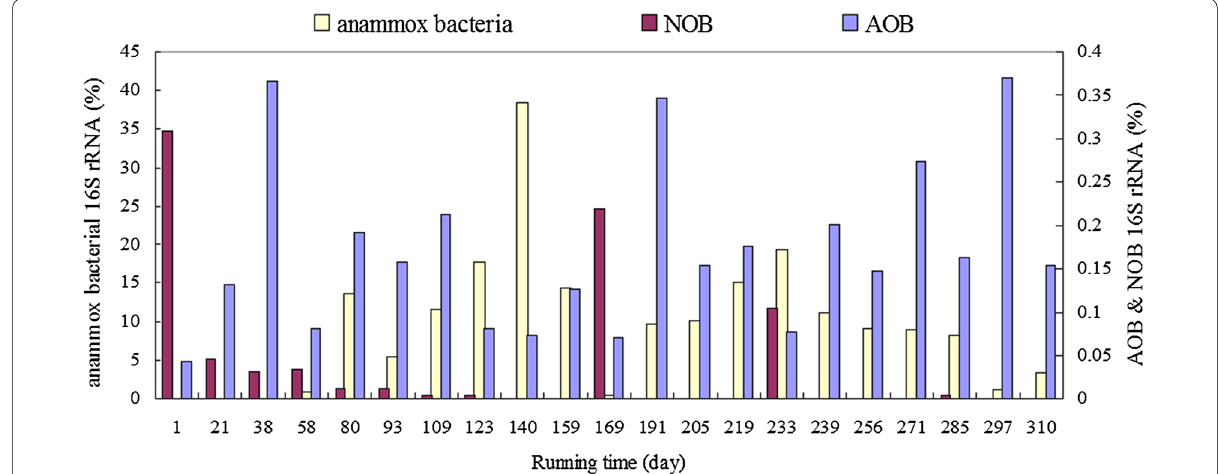
Fig. 5 Relative abundance of sequences related to anammox bacteria, NOB, and AOB in ANAMMOX, from bacterial 16S rRNA gene